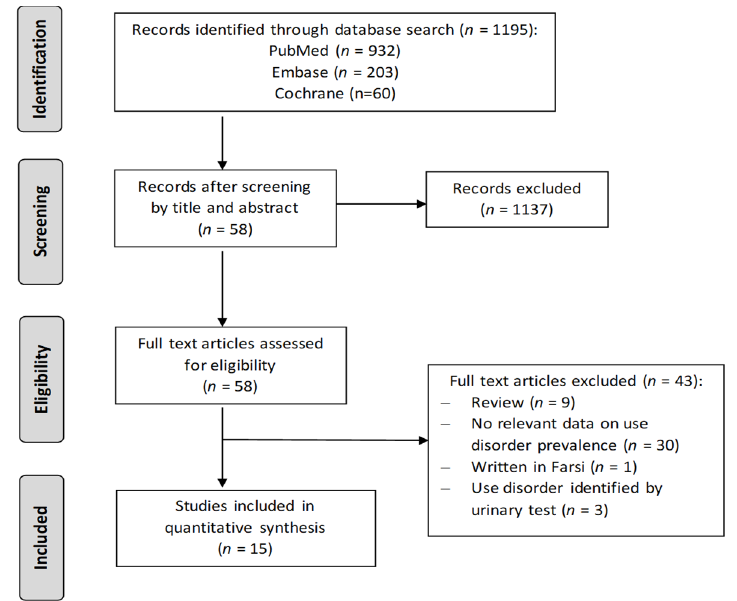
Figure 1. Flowchart of the study selection.